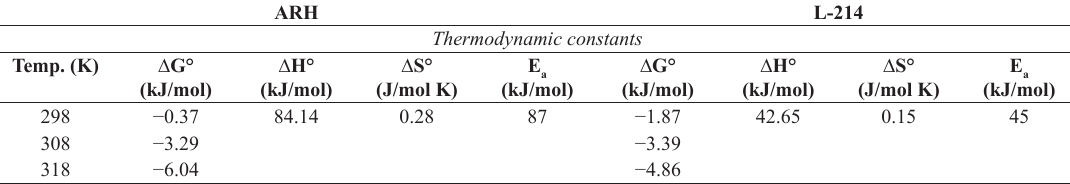
Table 5. Compositions of electronic waste mixture.